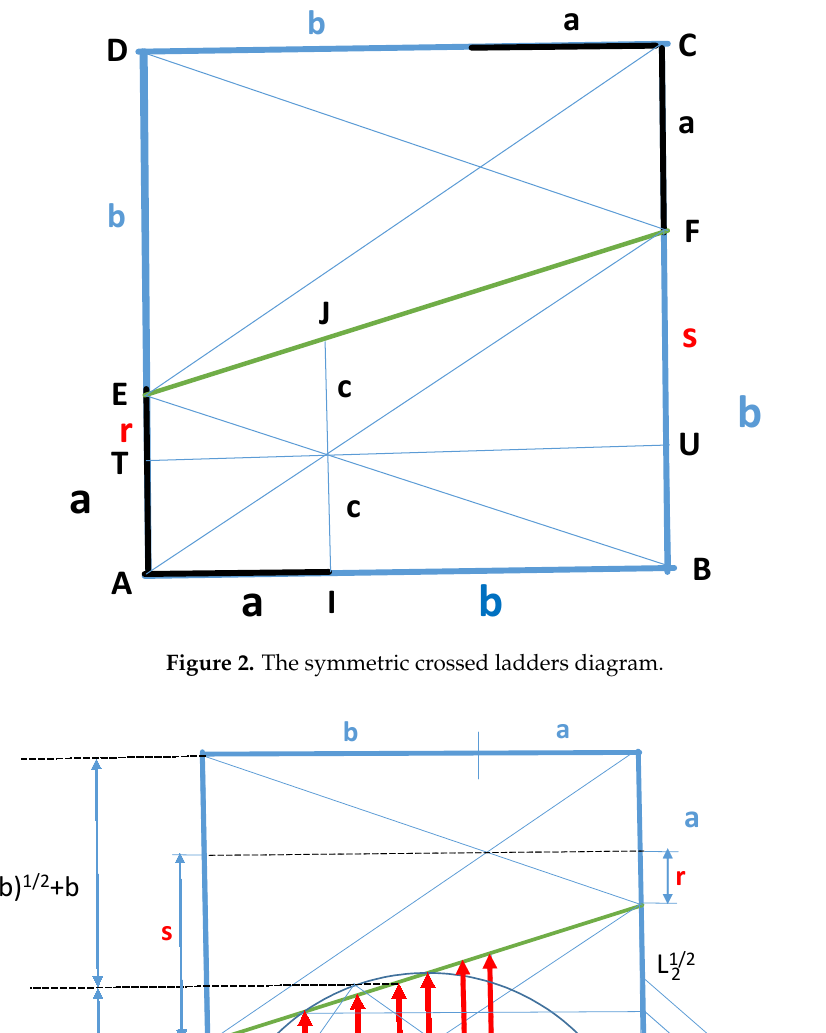
1 3 − 1 1 2 2 2 , L 0 , L , L 1 , L and L 2 2 2 2 2 2 2 2